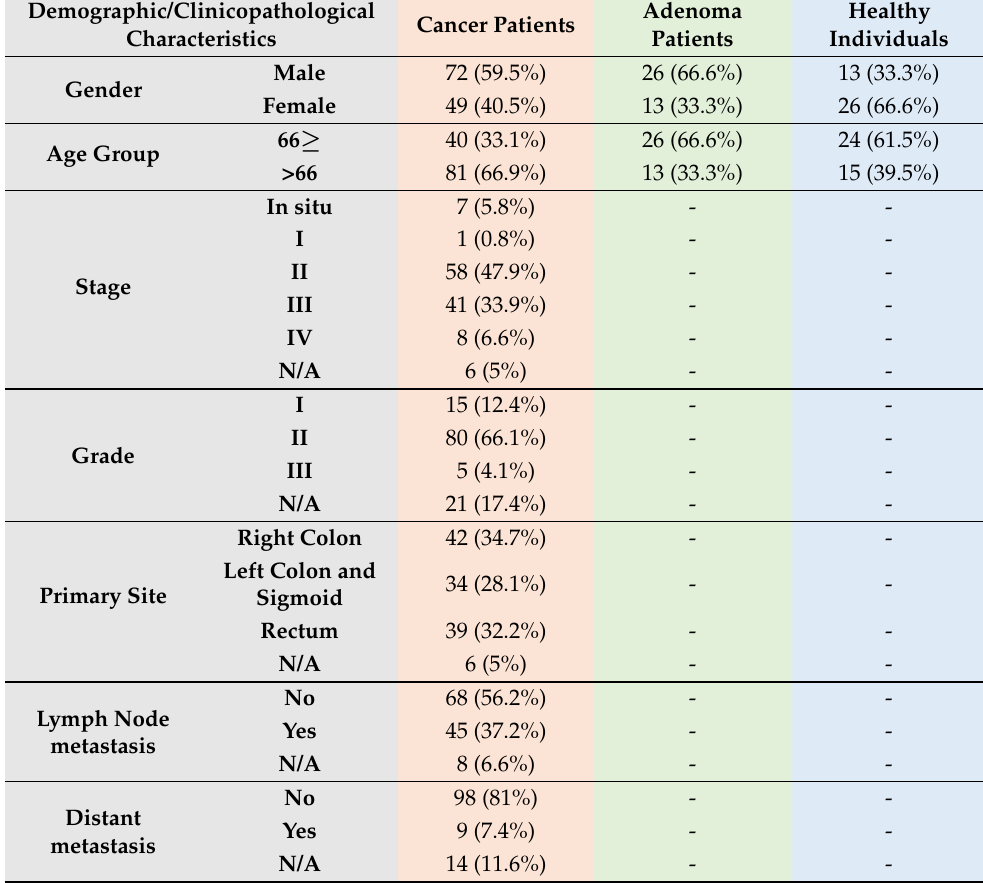
Table 1. Demographic and clinicopathological characteristics of colorectal cancer/adenoma patients and healthy controls. Abbreviations: N/A, not